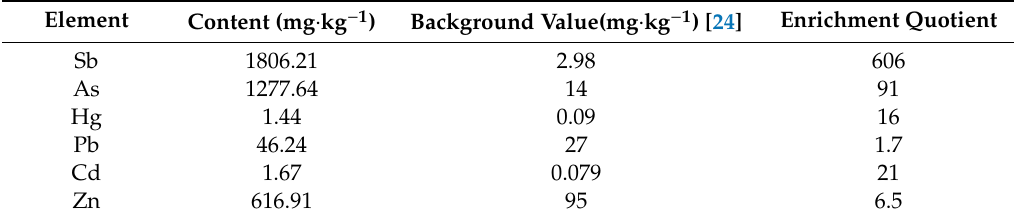
Table1. Averagecontentandrelativepollutionlevelsofpotentiallytoxicelements(PTEs)inwastematerials.